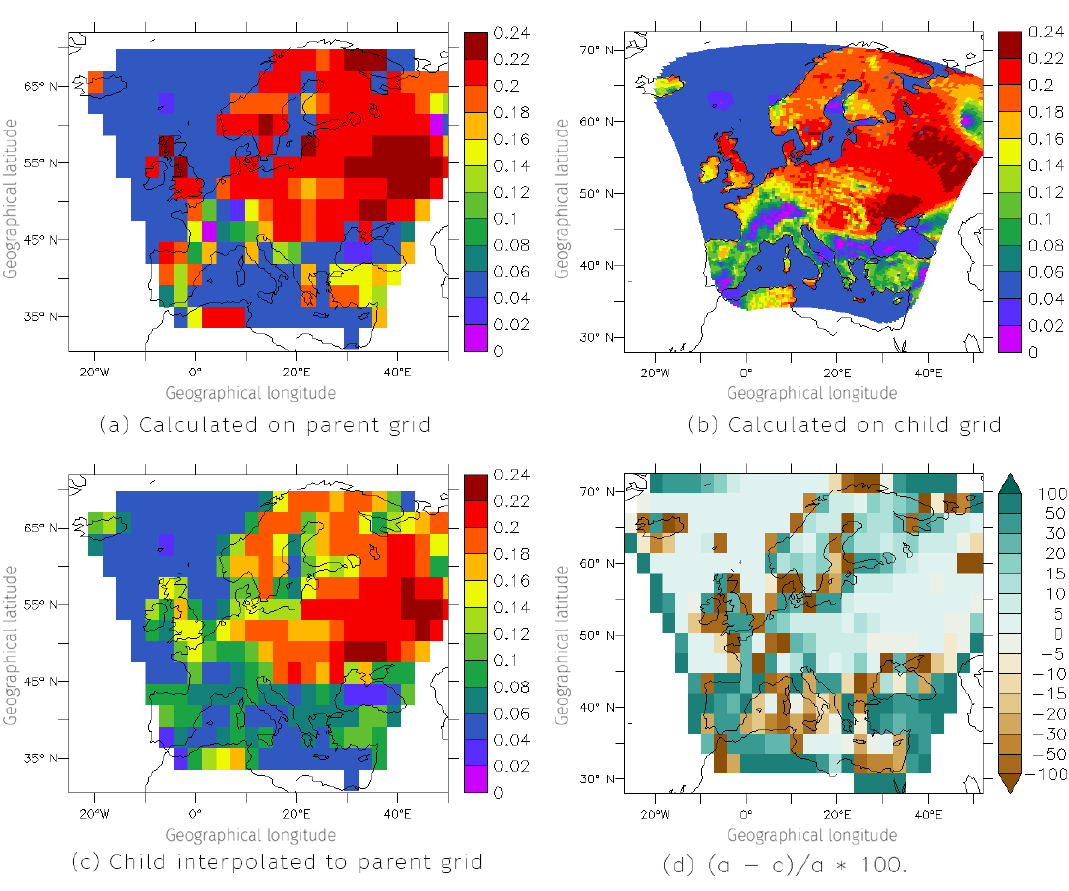
Figure 6. Ozone dry deposition velocities in cms − 1 for one distinct date in January 2003. The data have been masked to show only the coupled